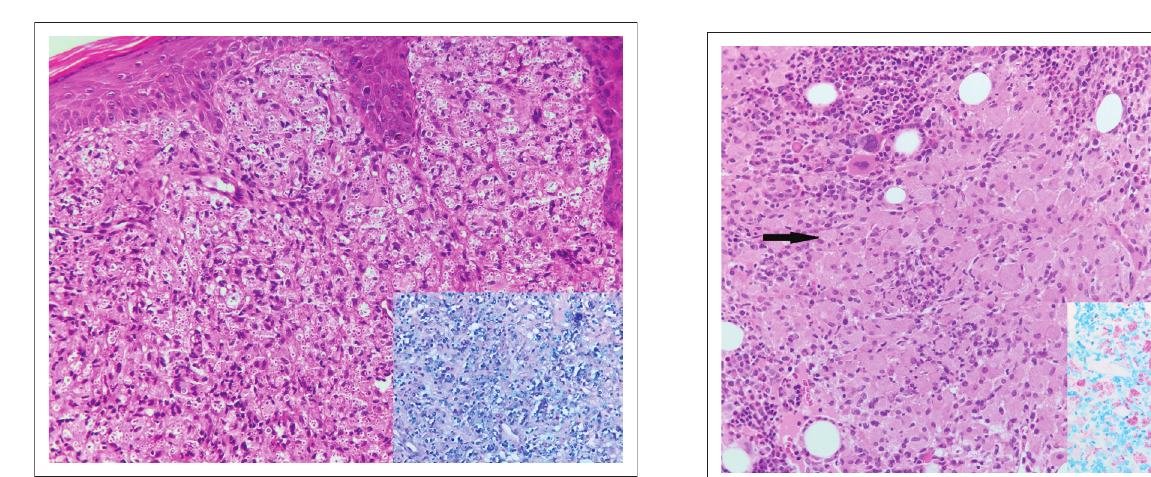
FIGURE 3: Bone marrow trephine biopsy showing histiocytes (arrows) (original magnification × 200) with acid fast bacilli in clumps on Ziehl Neelsen stain (inset) (original magnification ×